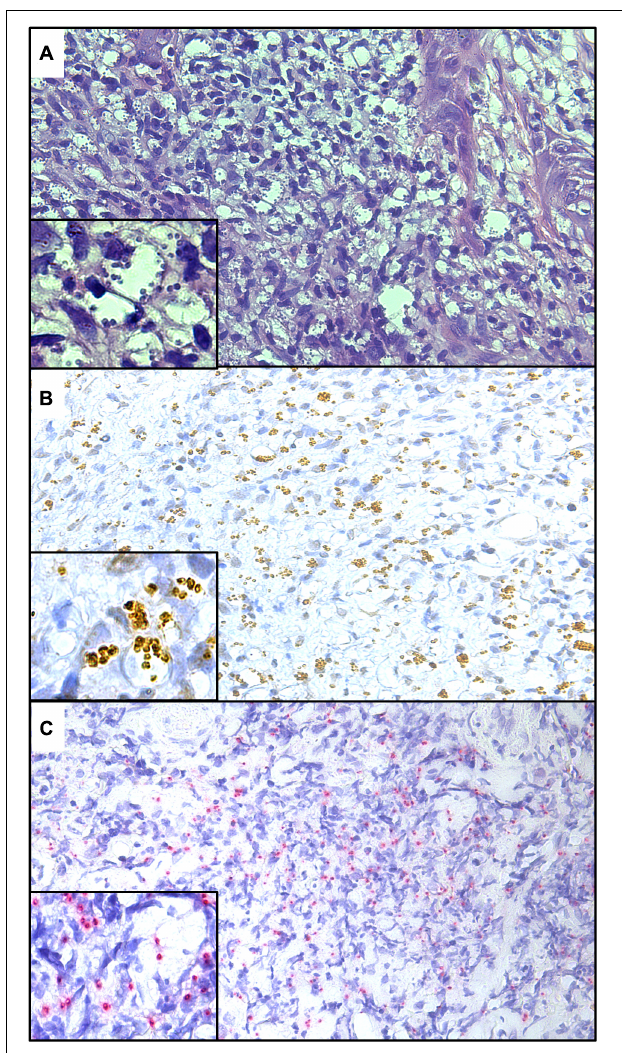
FIGURE 5 | Histological sections of skin lesions from patients with high parasite burden, stained by hematoxylin–eosin (A) , IHC-HRP (B) , and IHC-AP (C) (280 × ). Detail showing amastigote within parasitophorous vacuoles (700 × ).